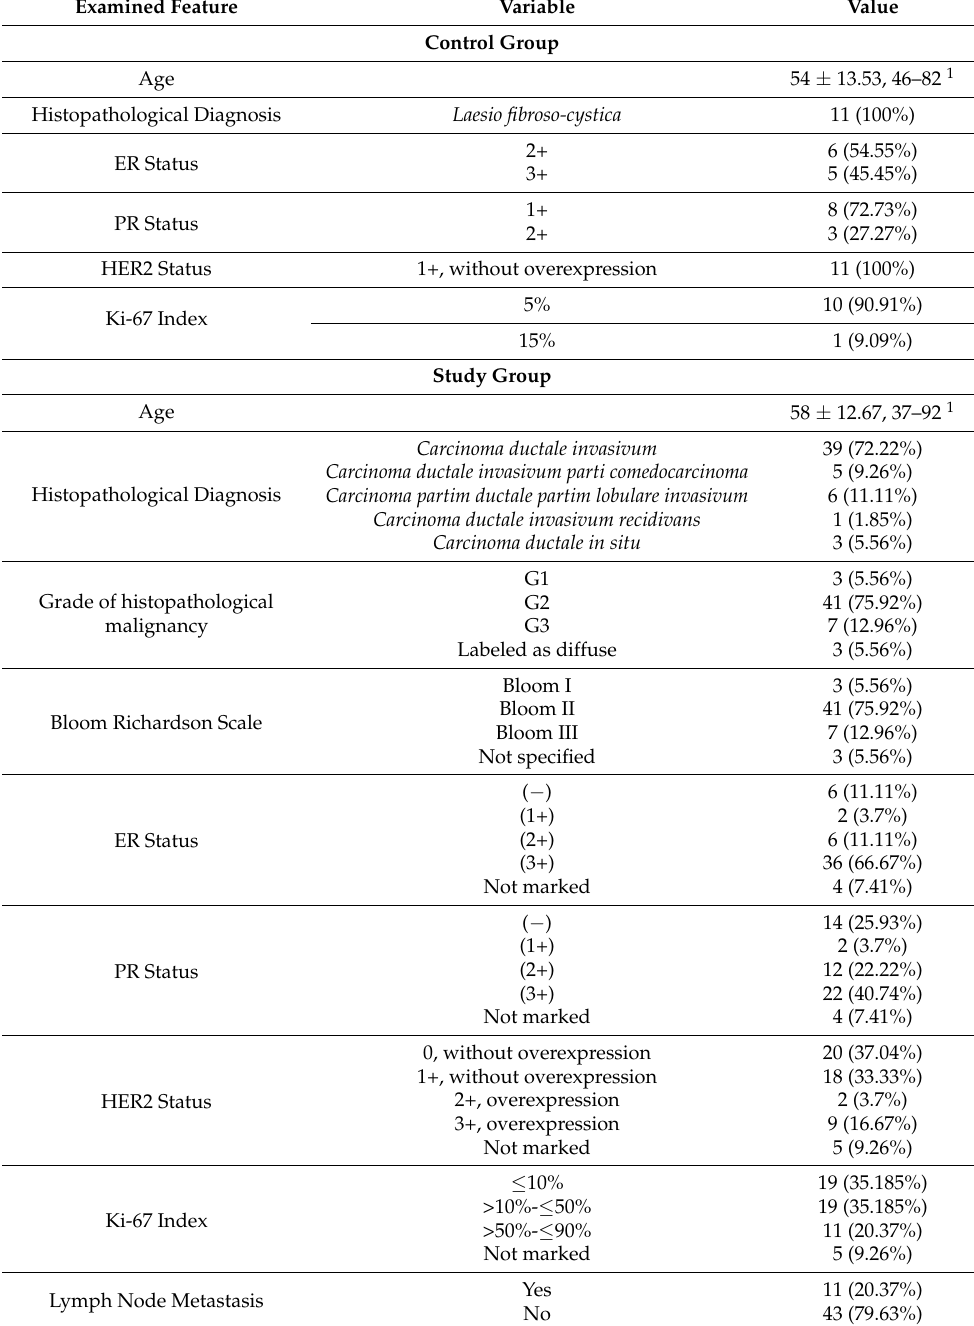
Table 5. Characteristics of the studied